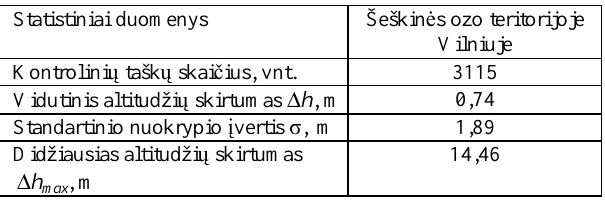
Table 5. Accuracy data of 50×50 m resolution DTM Statistiniai